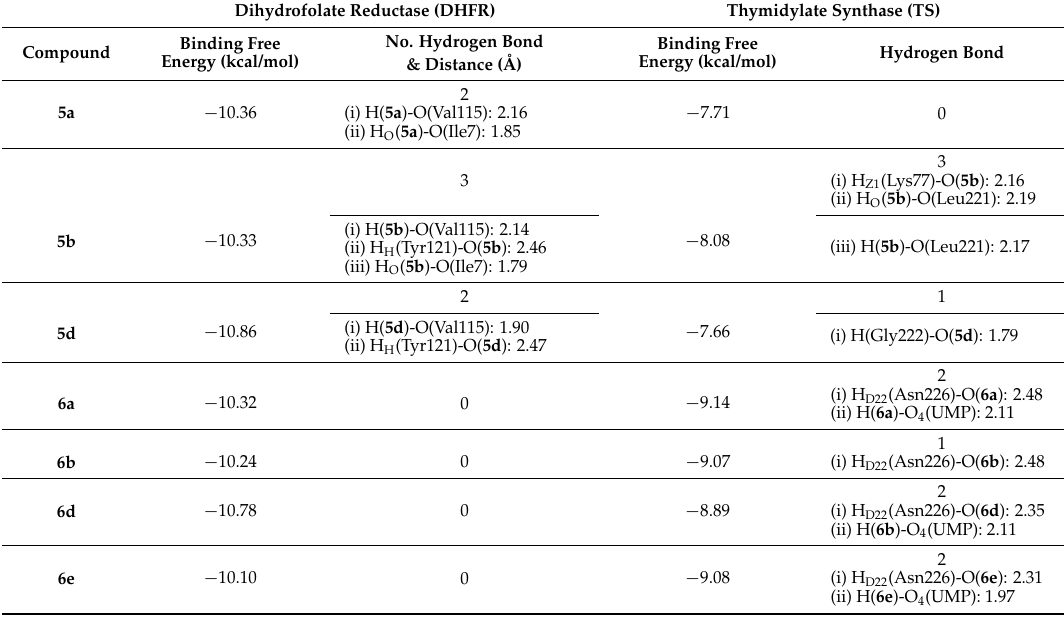
Table 4. Molecular docking results of test compounds against human dihydrofolate reductase (DHFR) and thymidylate synthase